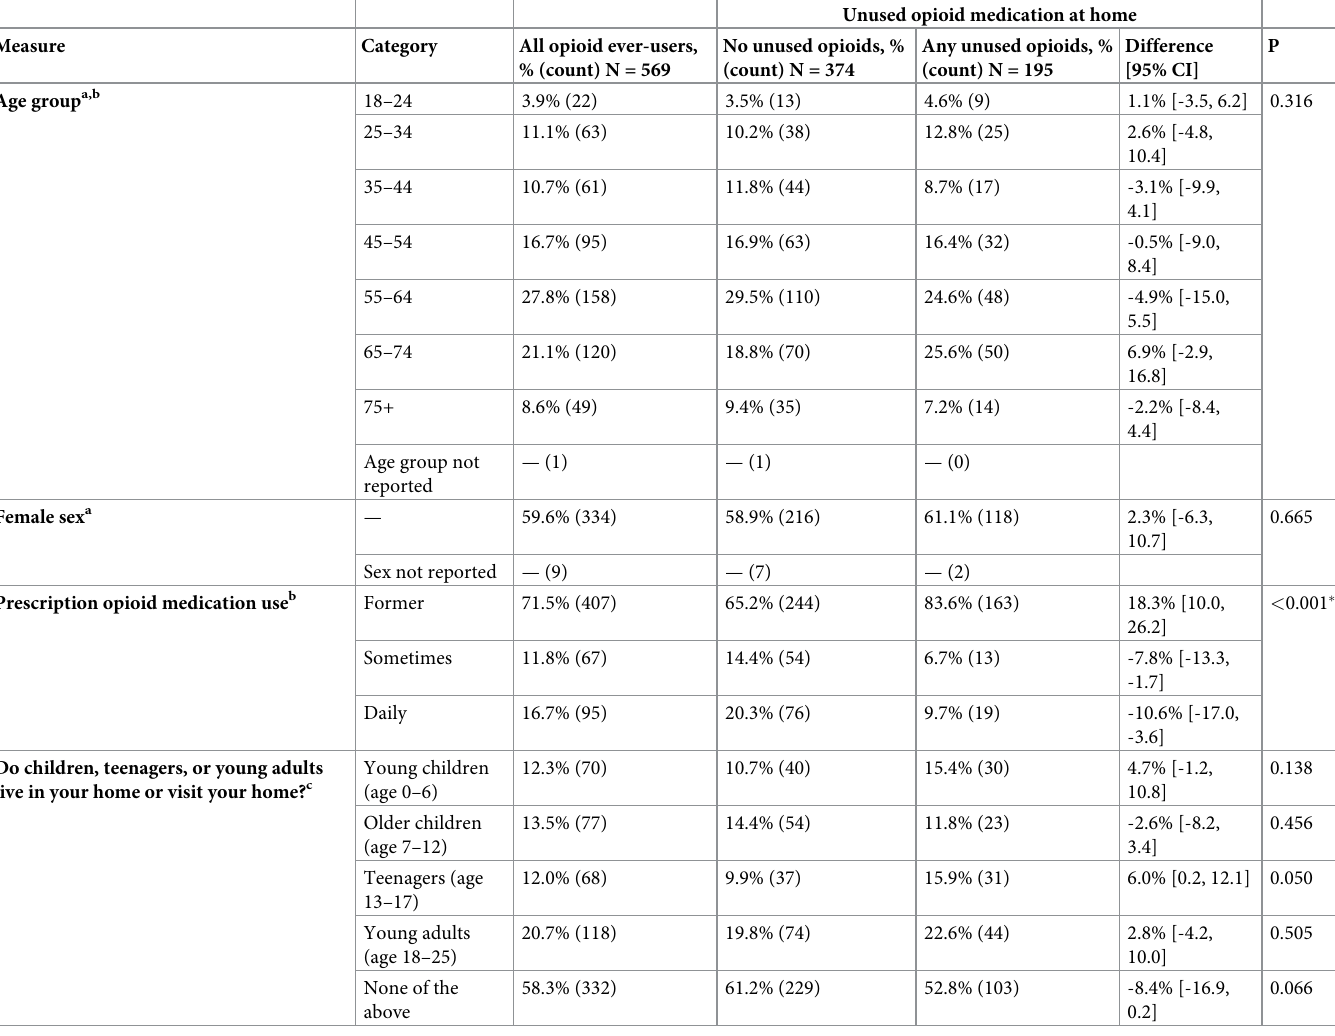
Table 1. Characteristics of opioid-using respondents, overall and by presence of unused opioids at